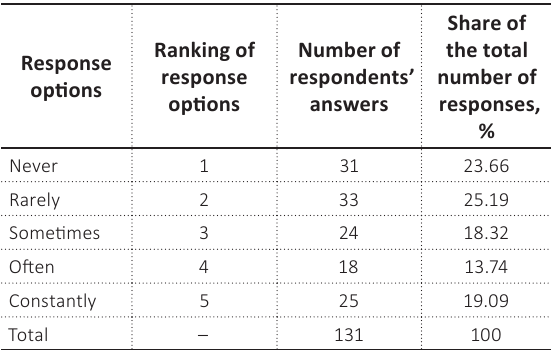
Table 4. The results of the survey “Do you conduct business research using digital tools?” Source: Calculated by the